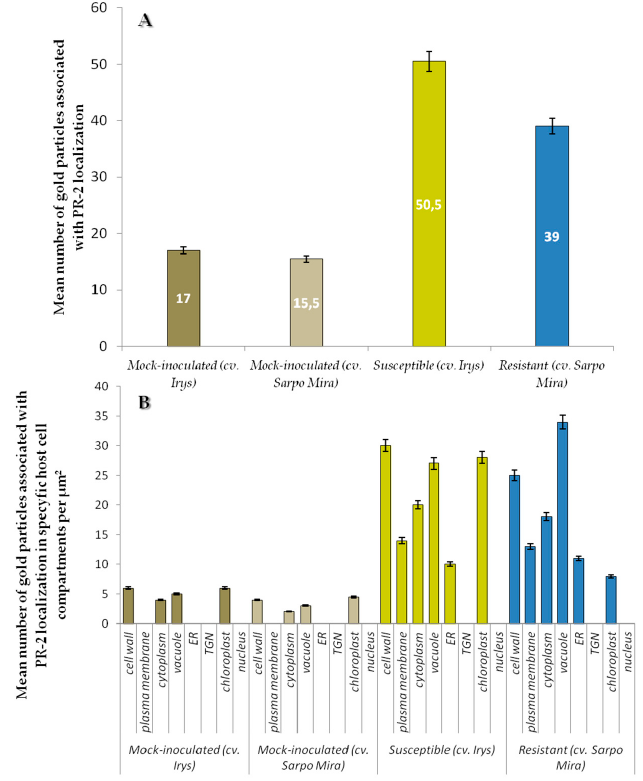
Figure 5. Statistical significance assessment of PR-2 epitopes immunogold localization ( A ) in mock-inoculated and PVY inoculated potato tissues of cultivars Irys (susceptible) and S á rpo Mira (resistant) & ( B ) in specific host cell compartments of mock-inoculated and PVY infected potato plants (susceptible and resistant). Figure presents mean numbers of gold particles located in specific compartment per µ m 2 . Quantification immunogold localization was prepared using ANOVA method. post-hoc Tukey HSD